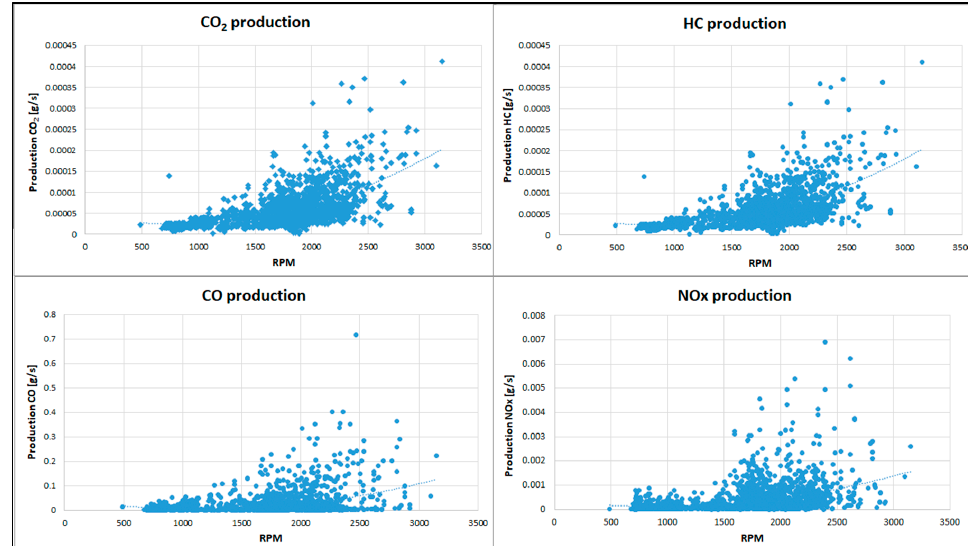
Energies 2022 , 15 , 1184 Figure 16. Comparison of emission production depending on engine speed—Petrol, urban cycle.